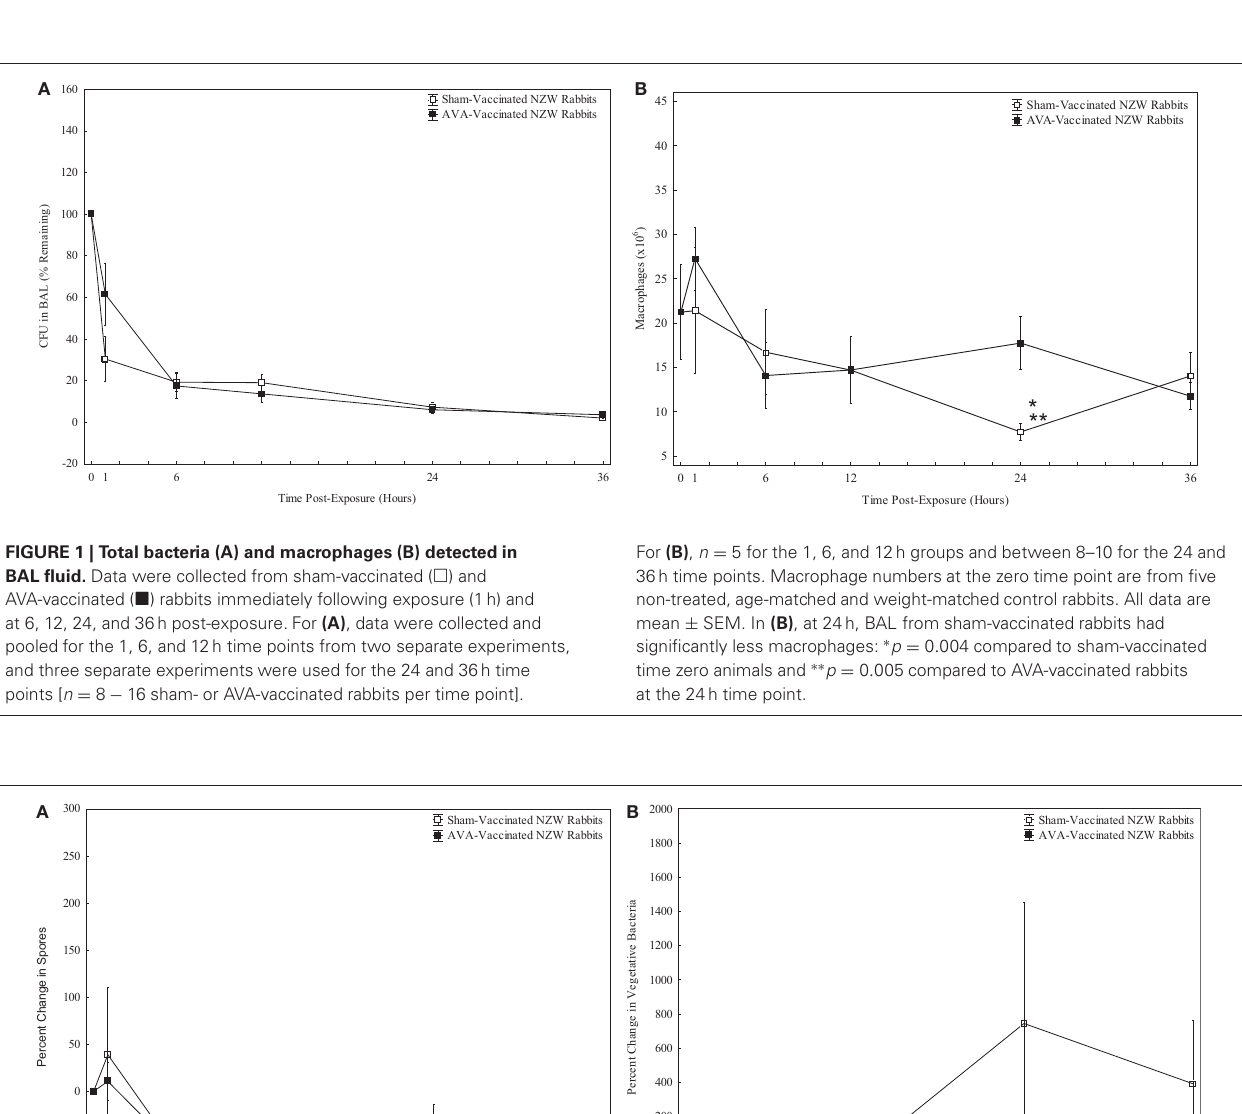
(increase or decrease) at a given time point relative to the initial lung tissue dose. All data are mean ± SEM with five animals per group except for 36h time point where data were pooled from two separate experiments ( n = 8 − 10